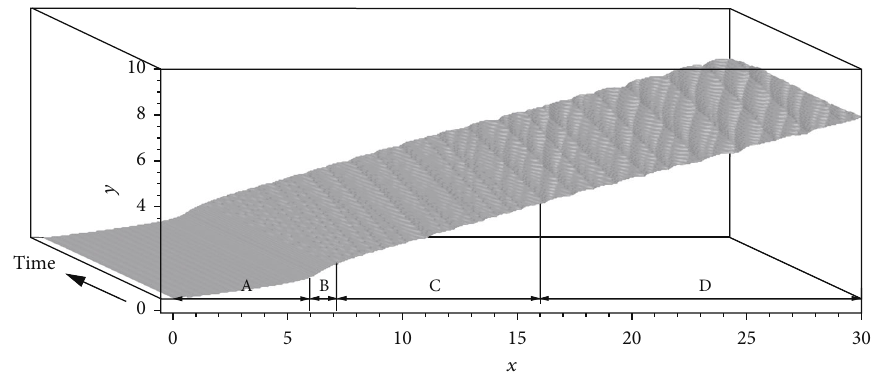
Figure 7: Numerical smoke foil record of cellular oblique